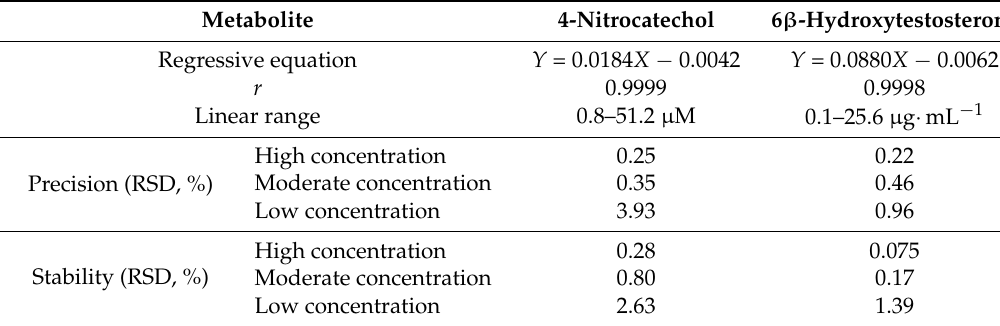
Table 1. Analytical